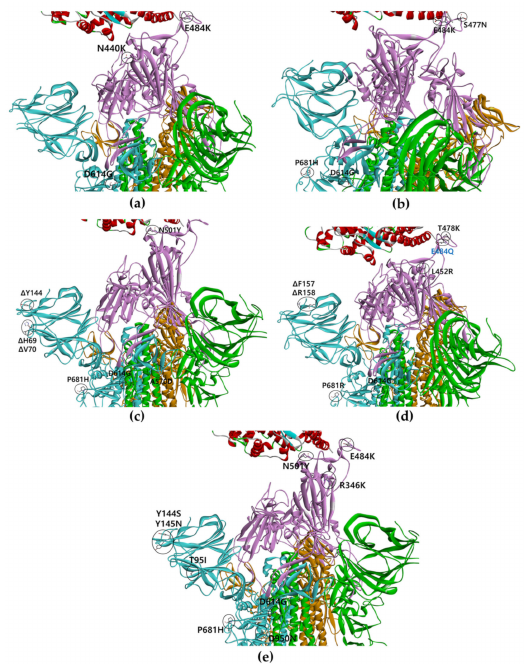
Figure 1. Mutation sites for S protein multiple variants. Trimeric RBDs in each chain are indicated in pink and ACE2 in red. Yellow, blue, and green colors indicate other domains except for RBD in each chain of the S protein. The black circular mark is the mutation site. ( a ) A double/triple mutant, ( b ) B.1.620, ( c ) alpha, ( d ) delta (E484Q mutation lacking in the Korean delta variant), and ( e ) mu